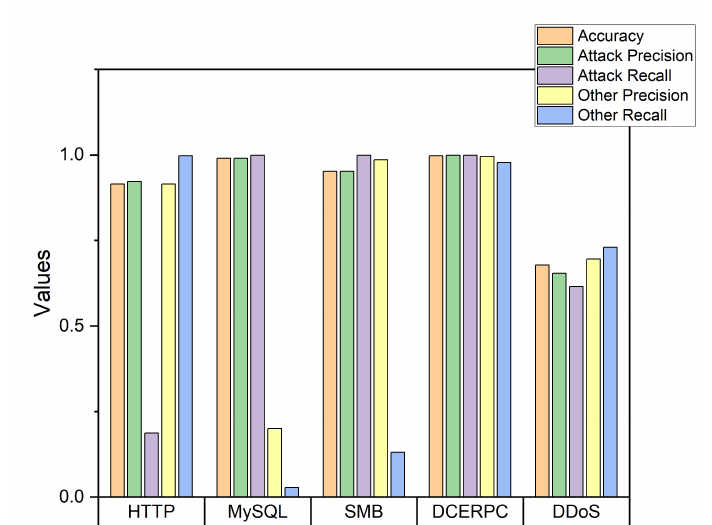
Figure 6. Performance of the unbalanced